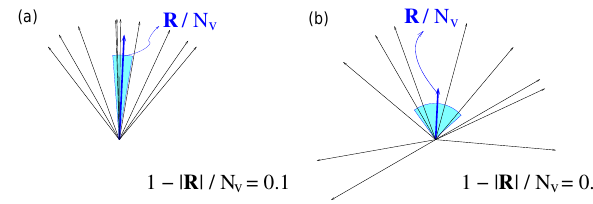
Figure 3. Graphical representation of the circular variance of terrain aspect, 1 −| R | /N v . Two groups of unit vectors are shown. The unit vectors represent the local direction of terrain aspect for each grid cell, resulting in circular variance (a) of 0.1 and (b) of 0.6. Unit vectors are perpendicular to the local topography, represented by the grid